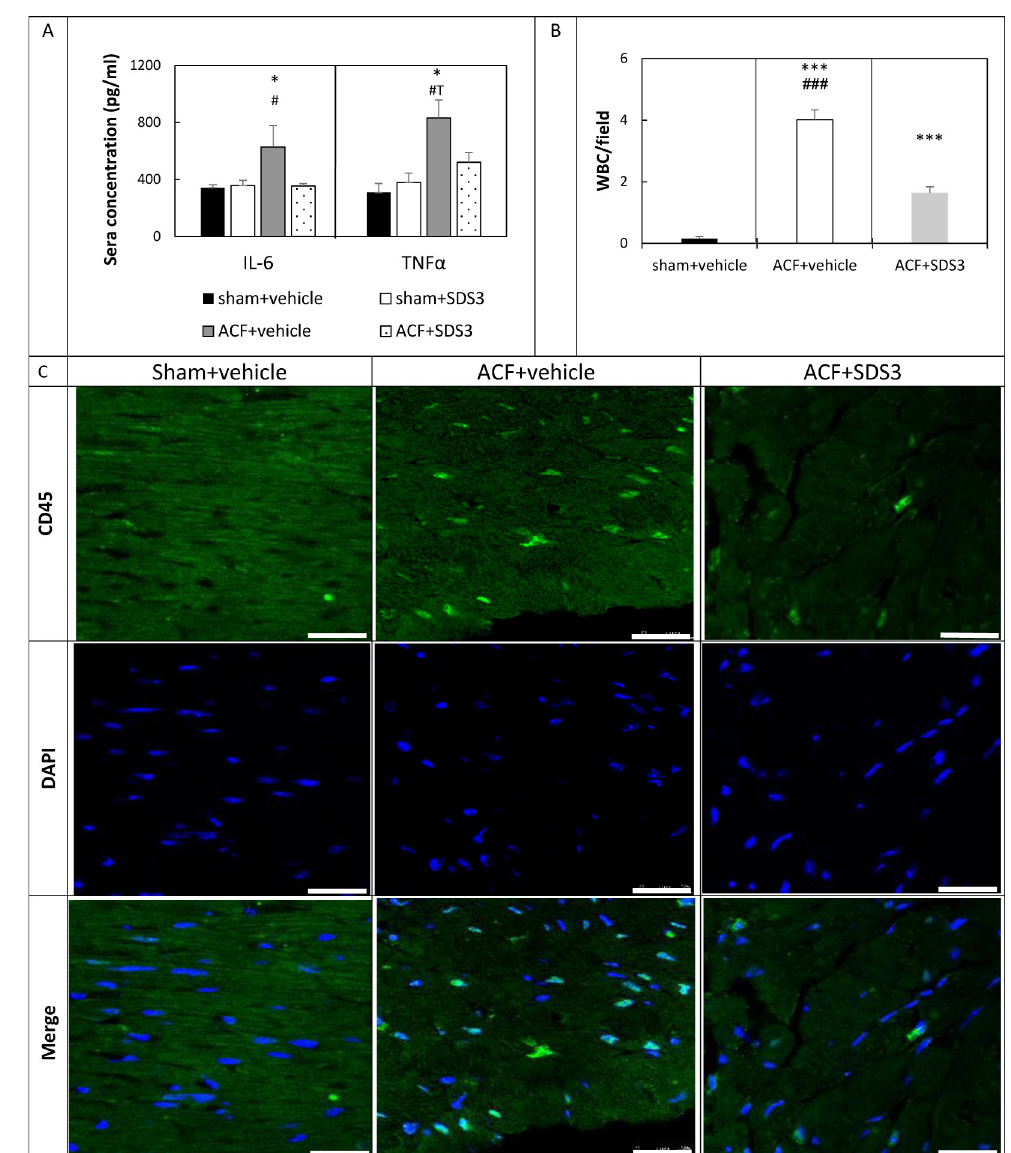
Fig 4. MMP9/2-mediated inflammation is reduced by SDS3. (A) TNF α and IL-6 concentration in sera of sham-vehicle (n = 6), sham-SDS3 (n = 6), ACF -vehicle (n = 6), and ACF-SDS3 (n = 8). Data are given as means ± SEM; � = P < 0.05 (relative to both sham+ vehicle and sham+SDS3), # = P < 0.05 (relative to ACF+SDS3). (B) Mean total number of white blood cells (WBC) per field (16 fields/ animal) in sham, vehicle-treated ACF and SDS3-treated ACF groups. ��� P < 0.001 (relative to sham), ### P < 0.001 (relative to ACF+SDS3). (C) Representative immunofluorescent images of CD45 expression (green) in LV sections. Scale bar -25 μ m. Dapi staining of nuclei is represented in blue.